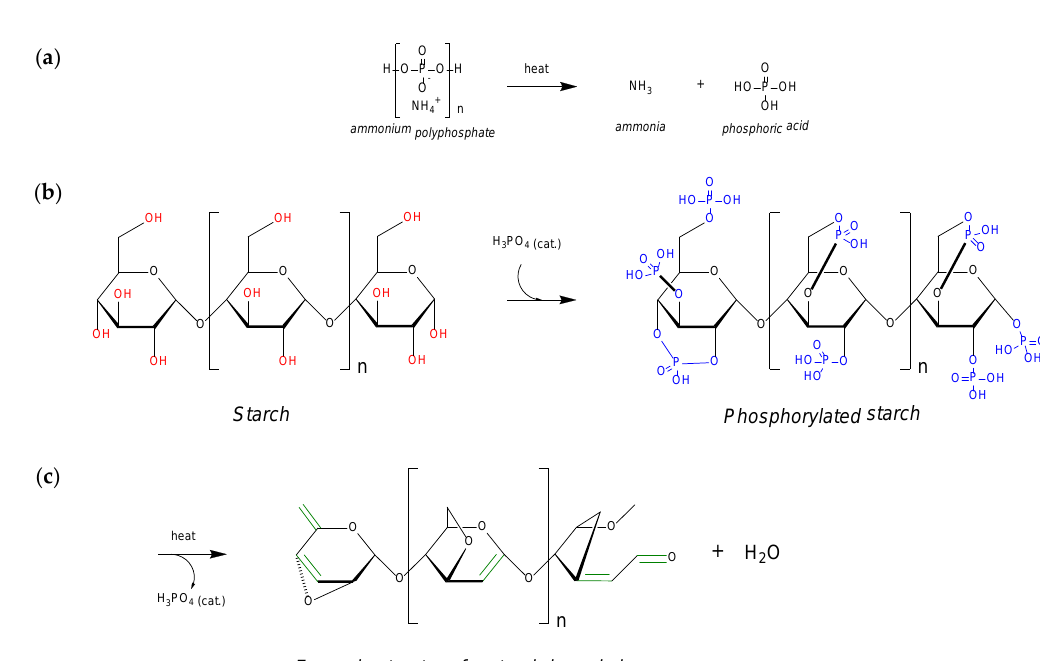
Figure 1. Thermal decomposition of ammonium polyphosphate into ammonia and ortho-phosphoric acid ( a ), Catalytic phosphorylation to produce phosphate esters ( b ), Dehydration of starch and formation of starch-based char structure ( c ).